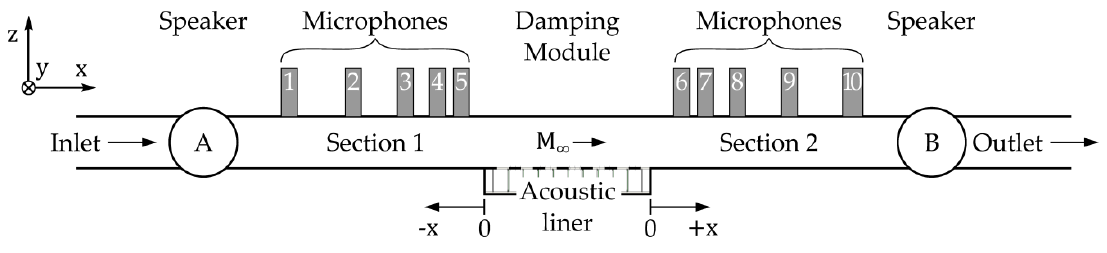
Figure 7. Sketch of acoustic test rig DUCT-R.